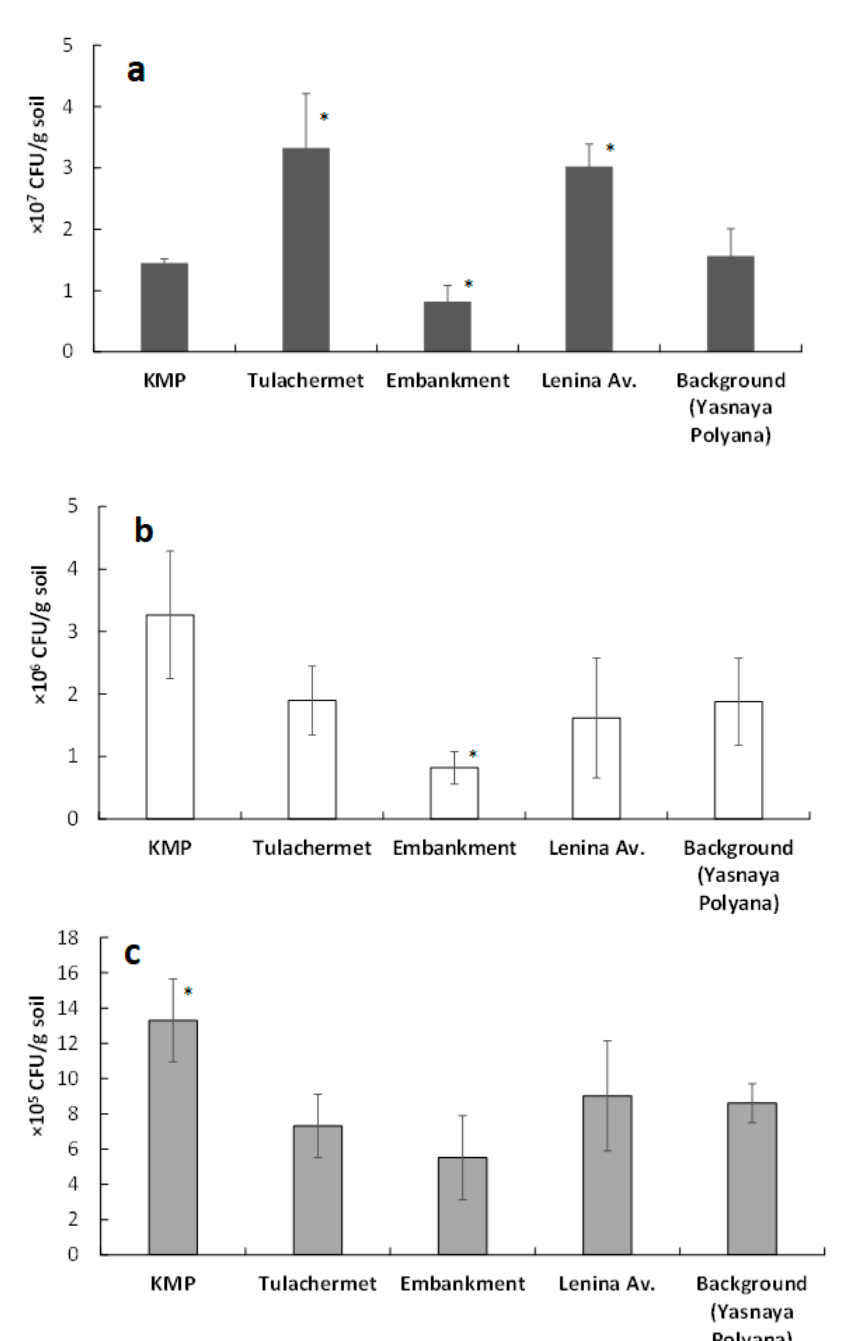
Figure 1. The number of cultivable heterotrophic bacteria, actinomycetes, and micromycetes in the rhizosphere of E. frumentacea . ( a )—bacteria; ( b )—actinomycetes; ( c )—micromycetes. Error bars mean standard errors/*— p < 0.05 for the difference between experimental and background samples.